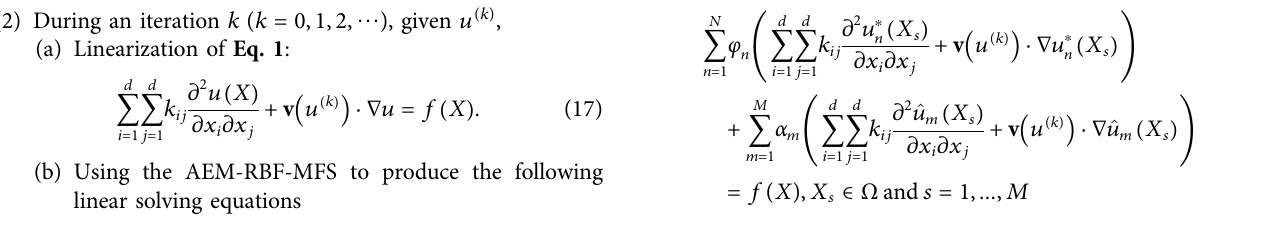
Frontiers in Physics |